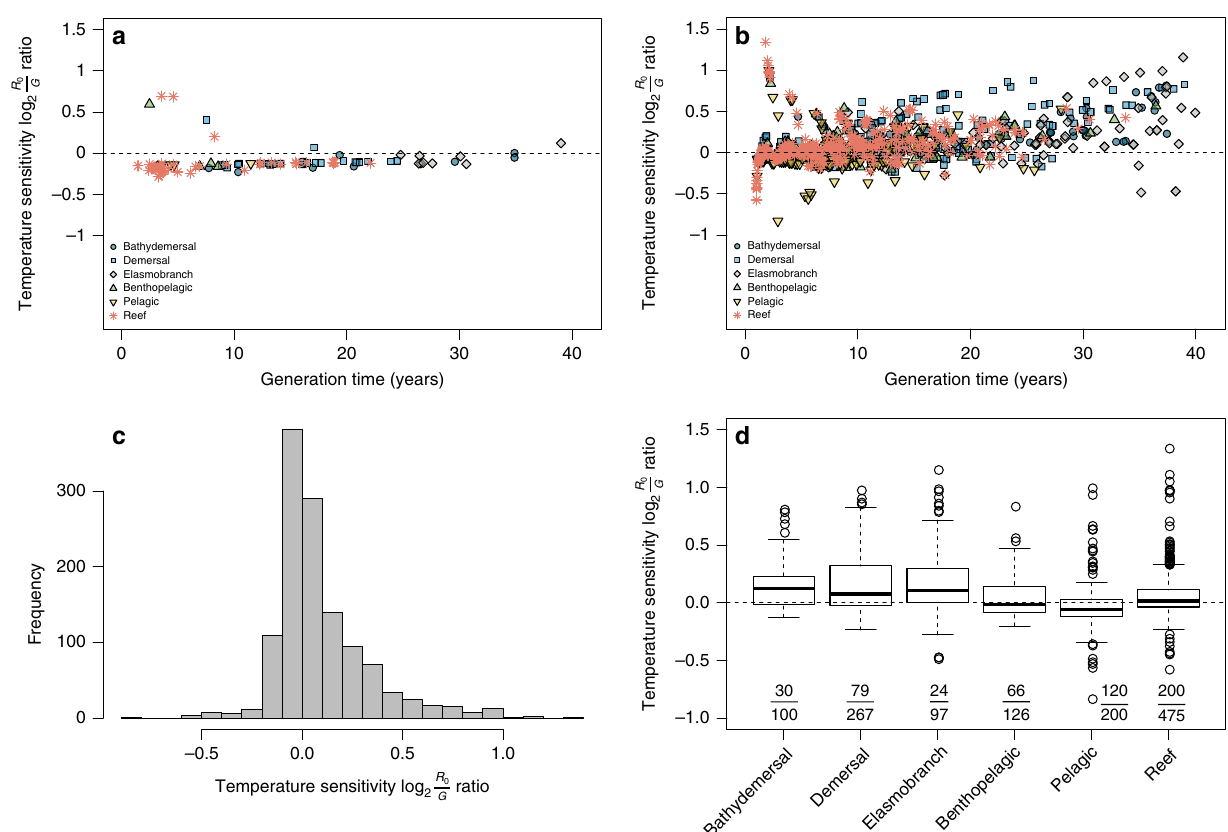
Fig. 4 Life-table prediction of temperature sensitivity for six groups of Indo-Paci fi c fi shes. Temperature sensitivity is quanti fi ed as the log 2 ratios of annual population growth for 1 °C temperature increase and for baseline temperature (log 2 R 0 G ratios). Relationships between the temperature sensitivity and generation time are shown for 100 fi sh populations with empirical body growth and maturation data ( a ) and 1265 populations with empirical body growth data and model-derived age-at-maturation data ( b ). A histogram of the log 2 R 0 G ratios ( n = 1265 populations) ( c ). Boxplots of log 2 R 0 G ratios with proportions of log 2 R 0 G ratios < 0 by groups ( n = 1265 populations) ( d ). The lower bounds, centers, and upper bounds of the boxes, respectively, correspond to the 25th, 50th, and 75th percentile of data values within each group. The whiskers extend to the most extreme data point no more than 1.5 times the interquartile range of data within each